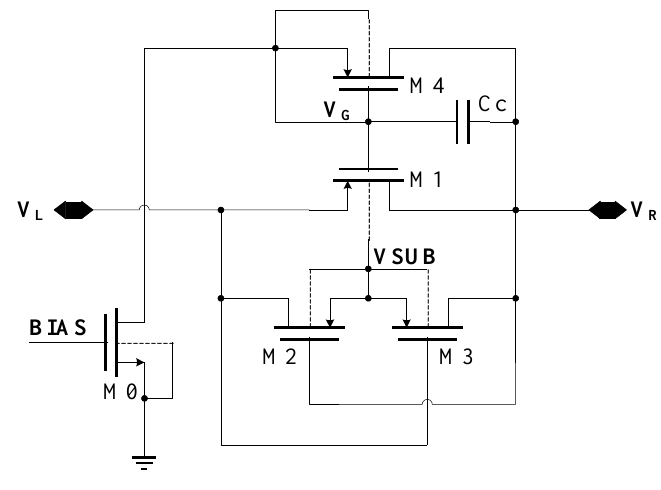
Figure 9. Schematic diagram of optimized diode-connected